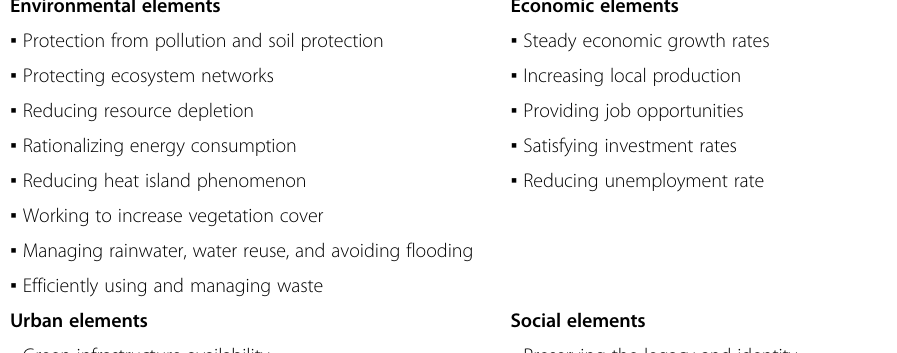
Table 1 The initial list of indicators of economic sustainability in cities. Source: Author, based on [12, 14, 15] Environmental elements Economic